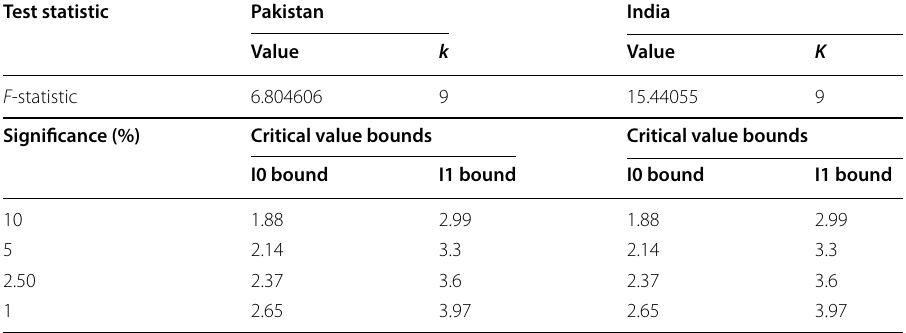
Table 2 Cotton total factor productivity (ARDL bound test) Test statistic